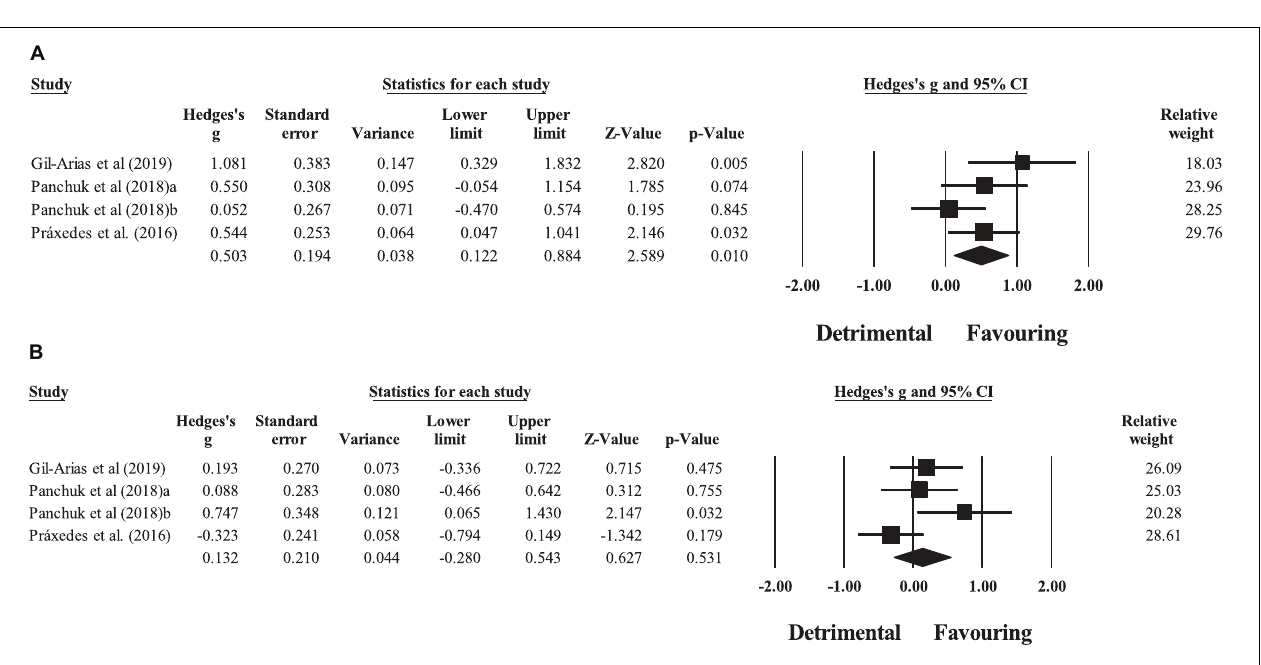
FIGURE 6 | Forest plot of within-group pre–post intervention changes in technical behavior, in youth athletes from team sports participating in (A) decision-making training and (B) control condition. Values shown are effect sizes (Hedges’s g ) with 95% confidence intervals (CI). The size of the plotted squares reflects the statistical (relative) weight of the